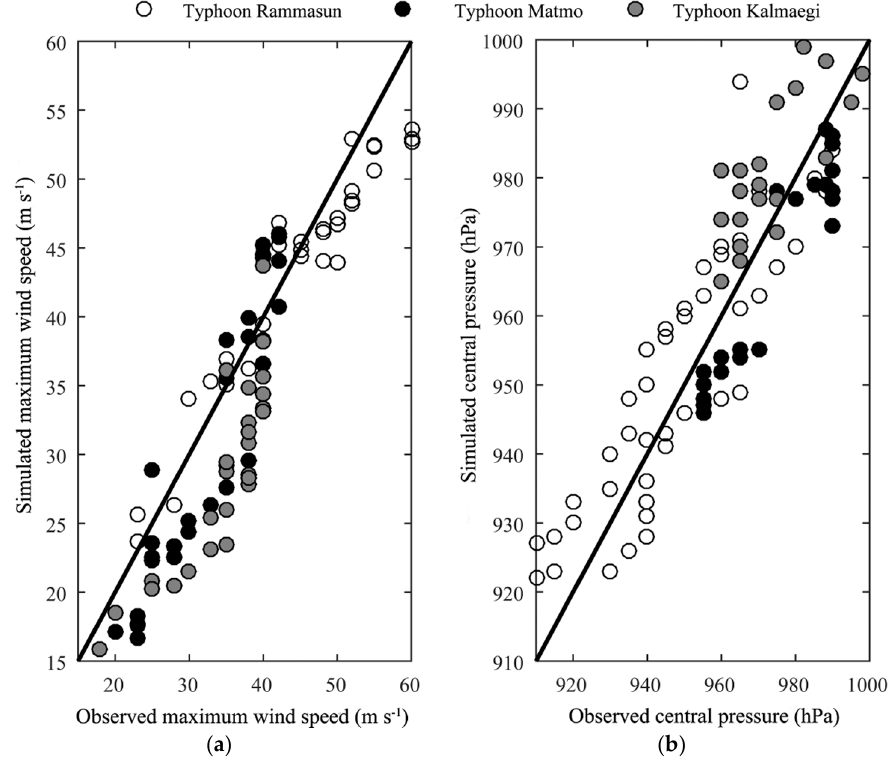
Figure 2. The comparisons of typhoon parameters derived from the numerical simulation results and public data during the passages of 3 typhoons: ( a ) maximum wind speed; and ( b ) central pressure.